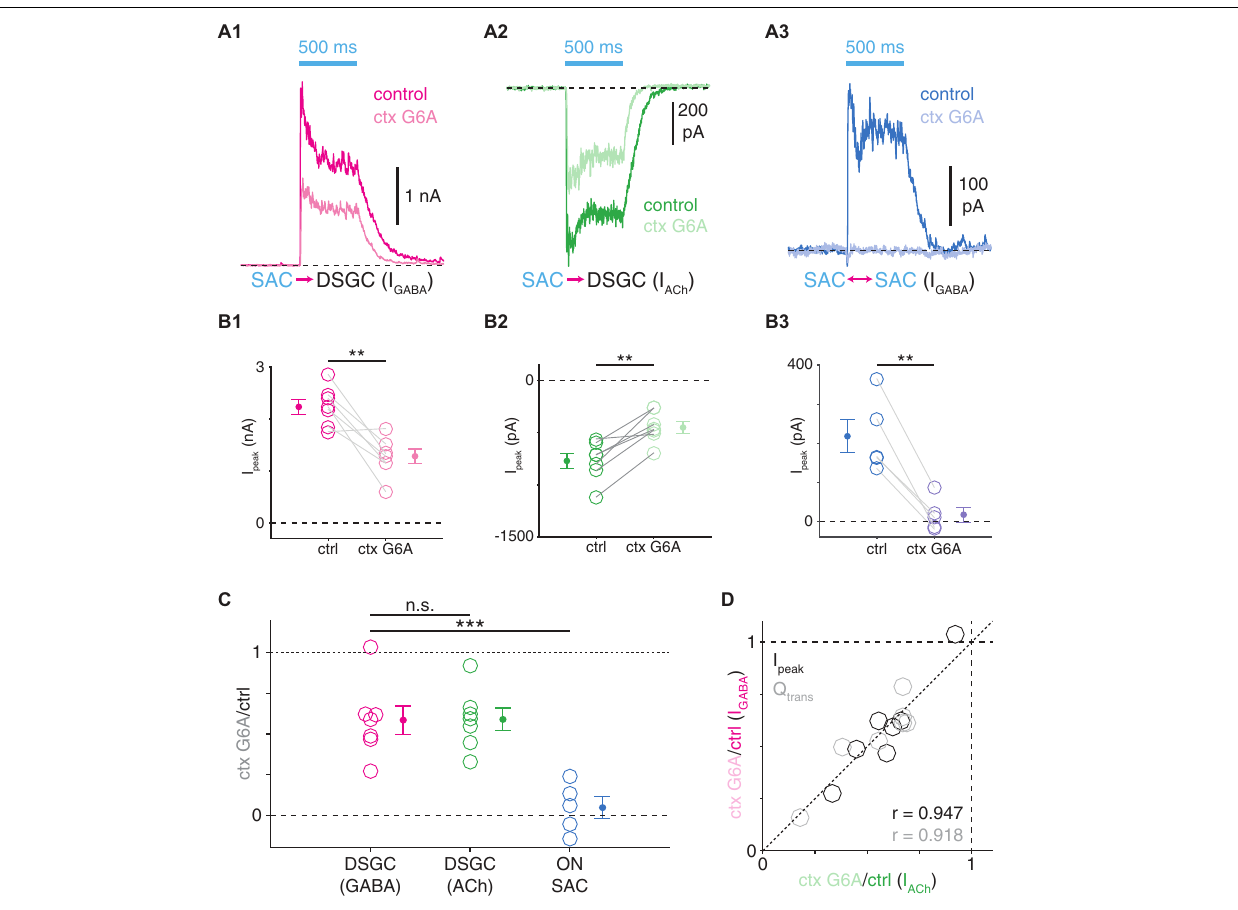
FIGURE 9 | Distinct VGCC populations mediate transmitter release from SAC synapses onto DSGCs and SACs. (A) ChR2-evoked IPSCs (A1) and EPSCs (A2) in ON-OFF DSGCs and IPSCs in ON SACs (A3) before and during bath application of ω -conotoxin G6A (ctx G6A, 300 nM), an N-type VGCC blocker. (B) Peak amplitudes (I peak ) of ChR2-evoked IPSCs ( B1 , n = 7) and EPSCs ( B2 , n = 7) in ON-OFF DSGCs and IPSCs in ON SACs ( B3 , n = 5) before and during ω -conotoxin G6A application. (C) Residual fractions of peak amplitude following ω -conotoxin G6A application. (D) ω -conotoxin G6A sensitivities of ChR2-evoked GABAergic IPSCs (I GABA ) and cholinergic EPSCs (I ACh ) measured in the same ON-OFF DSGCs ( n = 7). Residual fractions of peak amplitude (I peak ) or charge transfer (Q trans ) during ctx G6A application. n.s., not significant; ** p < 0.01; *** p <